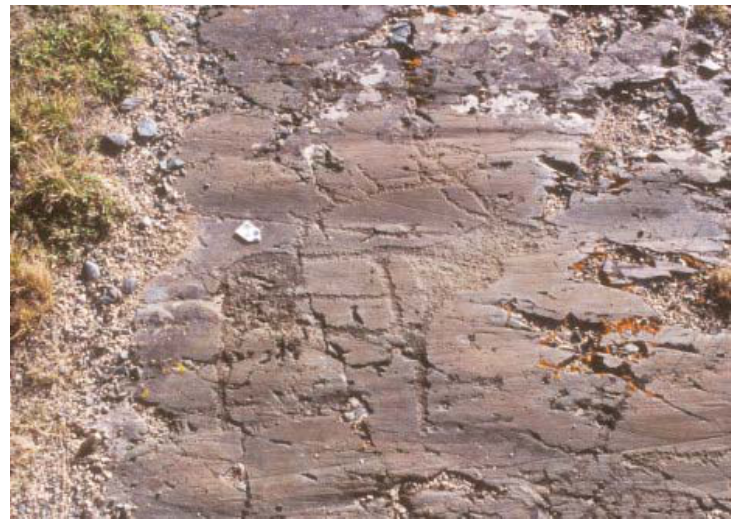
Figure 22. Elk partially silhouetted and possibly unfinished. Pre-Bronze Age or Early